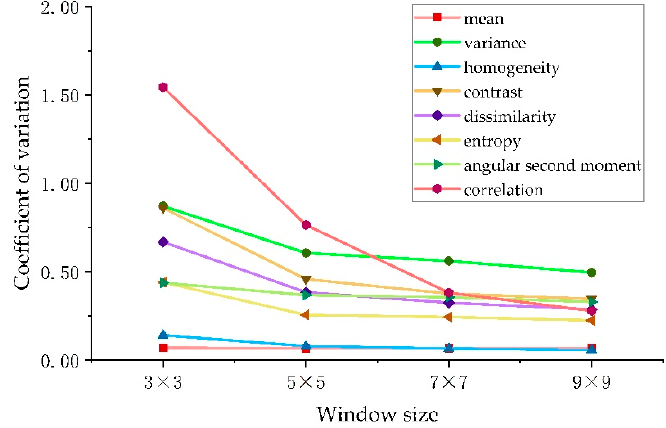
Figure A1. Change curve of CV with window size for some typical texture features.